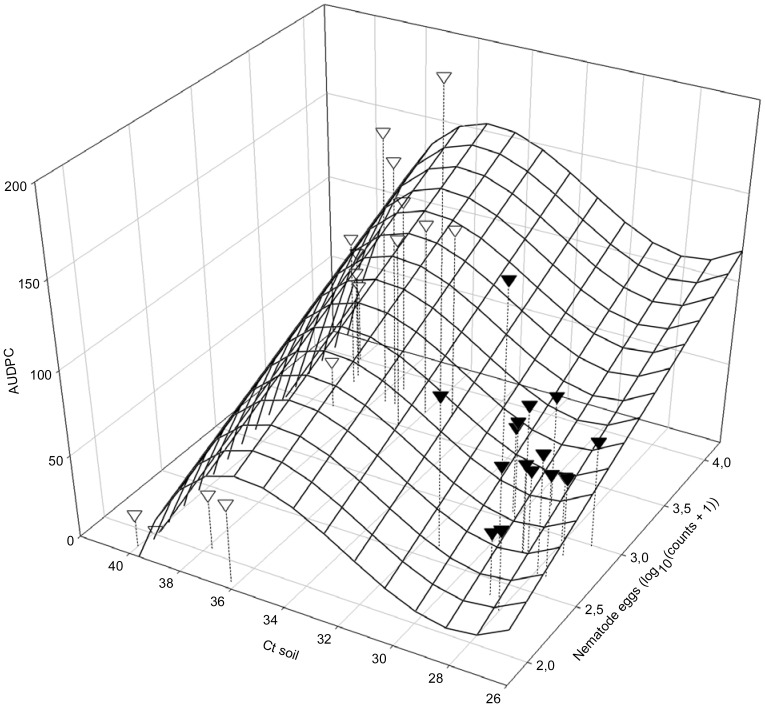
Value of AUDPC in relation to soil DNA of Fusarium virguliforme (Ct soil) and population densities of Heterodera glycines (LogPiH.glycines) at planting:AUDPC  = 7340.30312+34.96268 LogPiH.glycines −717.74671 Ct soil +23.01140 Ct soil2 −0.24258 Ct soil3; R
2 = 0.6804; Pi = 0.0035; Pa<0.01; Pb = 0.0024; Pc = 0.0024; ∇: 2006; ▾: 2007.